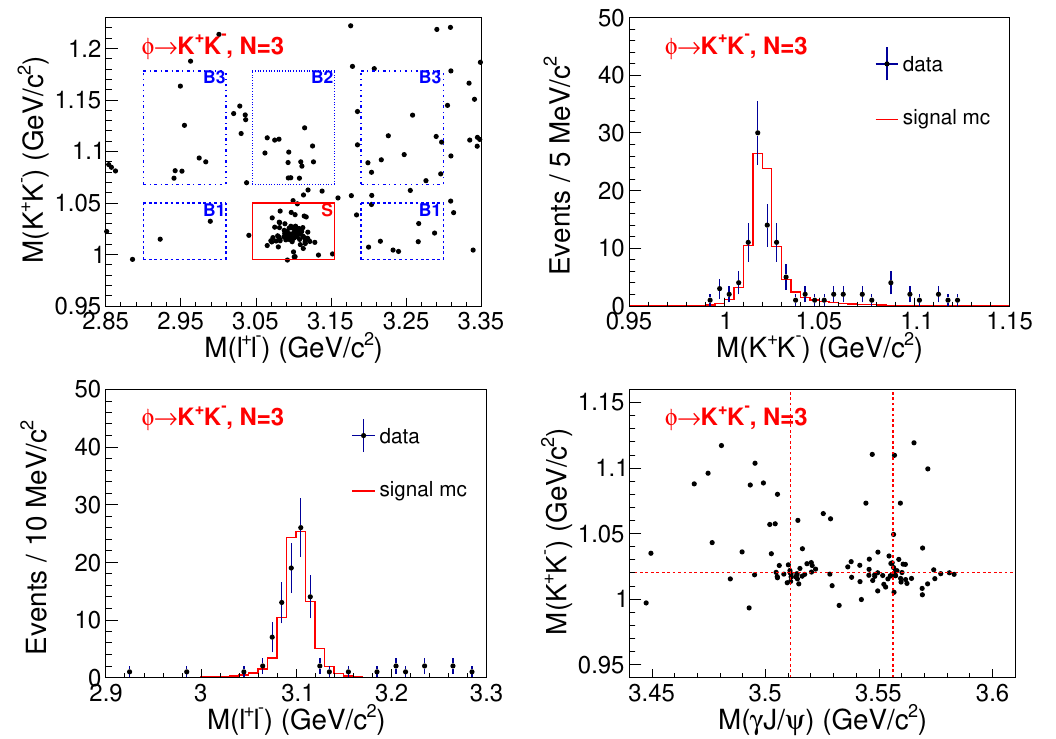
Figure 1 . The 2-dimensional distribution of the M ( K + K − ) versus M ( ‘ + ‘ − ) (upper left), the invariant mass distributions of the M ( K + K − ) (upper right), M ( ‘ + ‘ − ) (bottom left) and the 2- dimensional distribution of the M ( K + K − ) versus M ( γJ/ψ ) (bottom right) for the 3-track events in the φ → K + K − mode. Dots with and without error bars are the full data, the red histograms are the signal MC. In the upper left panel, the red solid box is the φJ/ψ signal region (S), the blue dashed, dotted and dash-dotted boxes indicate the φ non- J/ψ (B1), J/ψ non- φ (B2) and non- φ non- J/ψ (B3) sideband regions, respectively. The vertical (horizontal) dashed lines in the bottom right panel are central masses of χ c 1 /χ c 2 ( φ